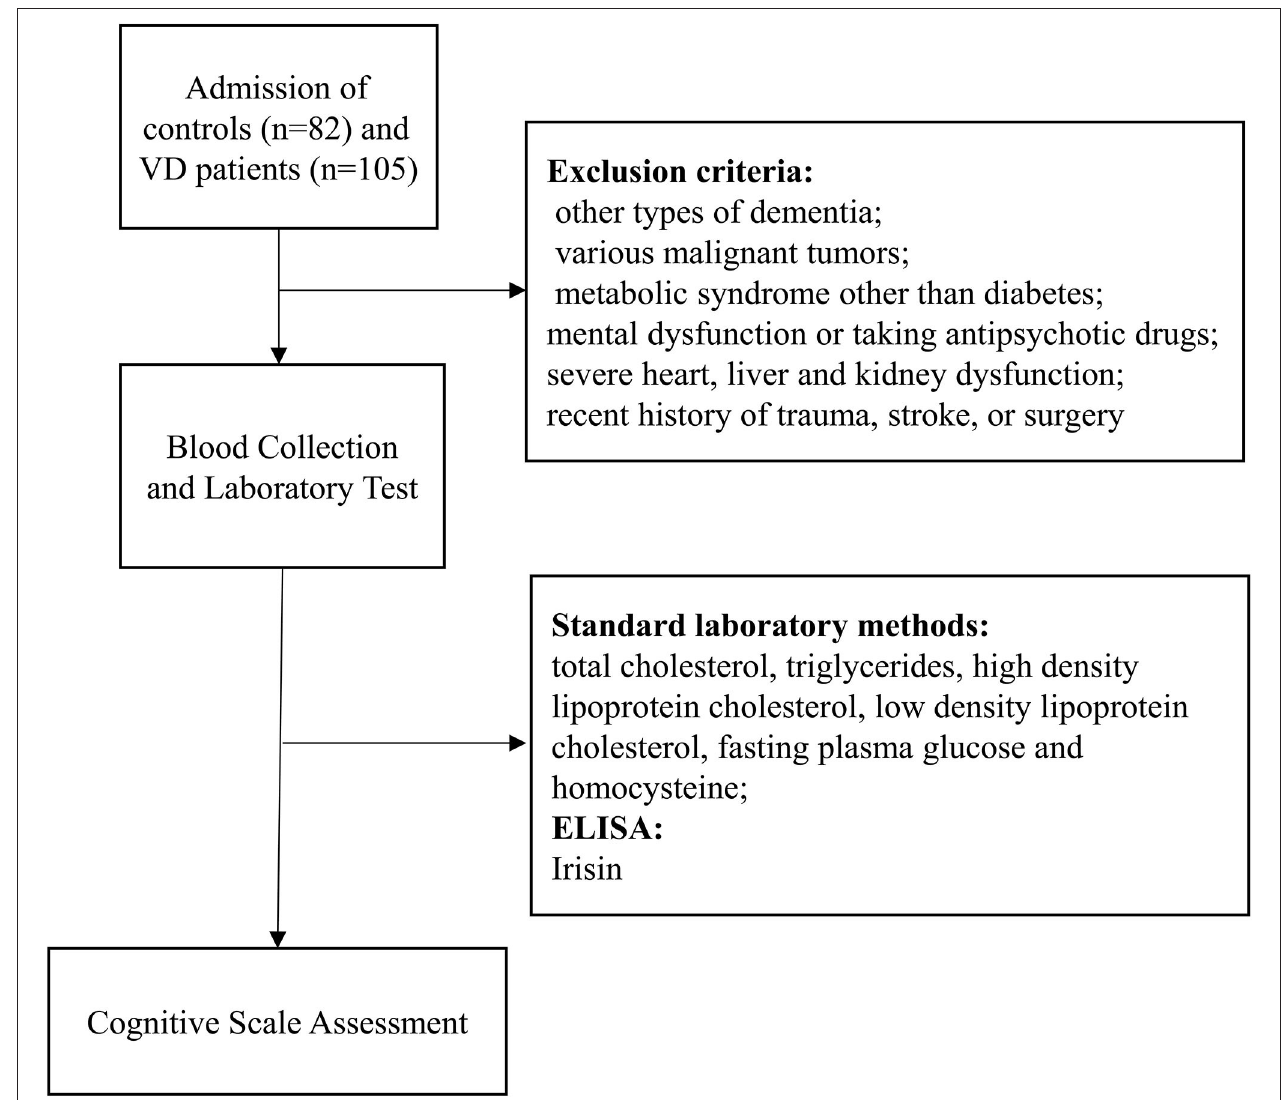
FIGURE 1 | Flow chart of the study